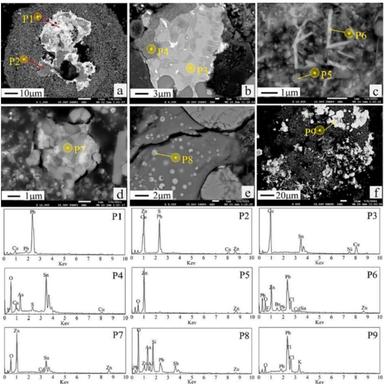
Characteristics of the raw materials: (a–f) SEM-EDS of the representative phases at high magnification (1000 × –20000 × ). X-ray energy dispersive spectrum P1 is for Pb, P2 for sulfide, P3 for Cu-sn-Ni alloys, P4 for tin oxide containing As, P5 for ZnO, P6 for PbCl2 containing F, Br, Zn, and Cd, P7 for Zn2SnO4 containing Cd, P8 for arsenic-antimony compound included in silicate, and P9 for halides of lead, potassium, and thallium.